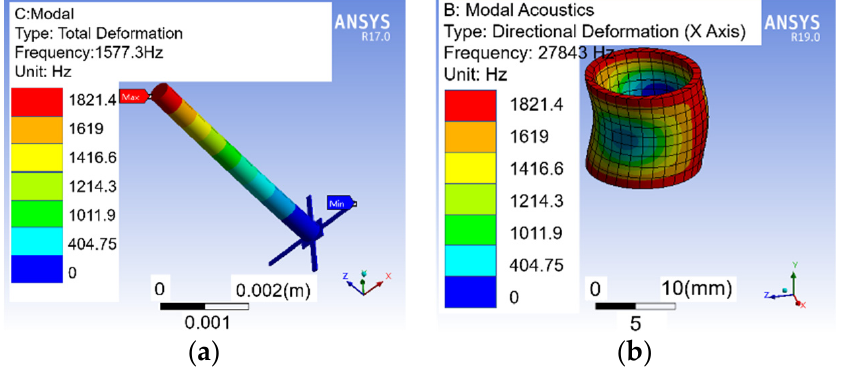
Figure 10. First-order modal analysis. ( a ) Vector channel; ( b ) scalar channel.